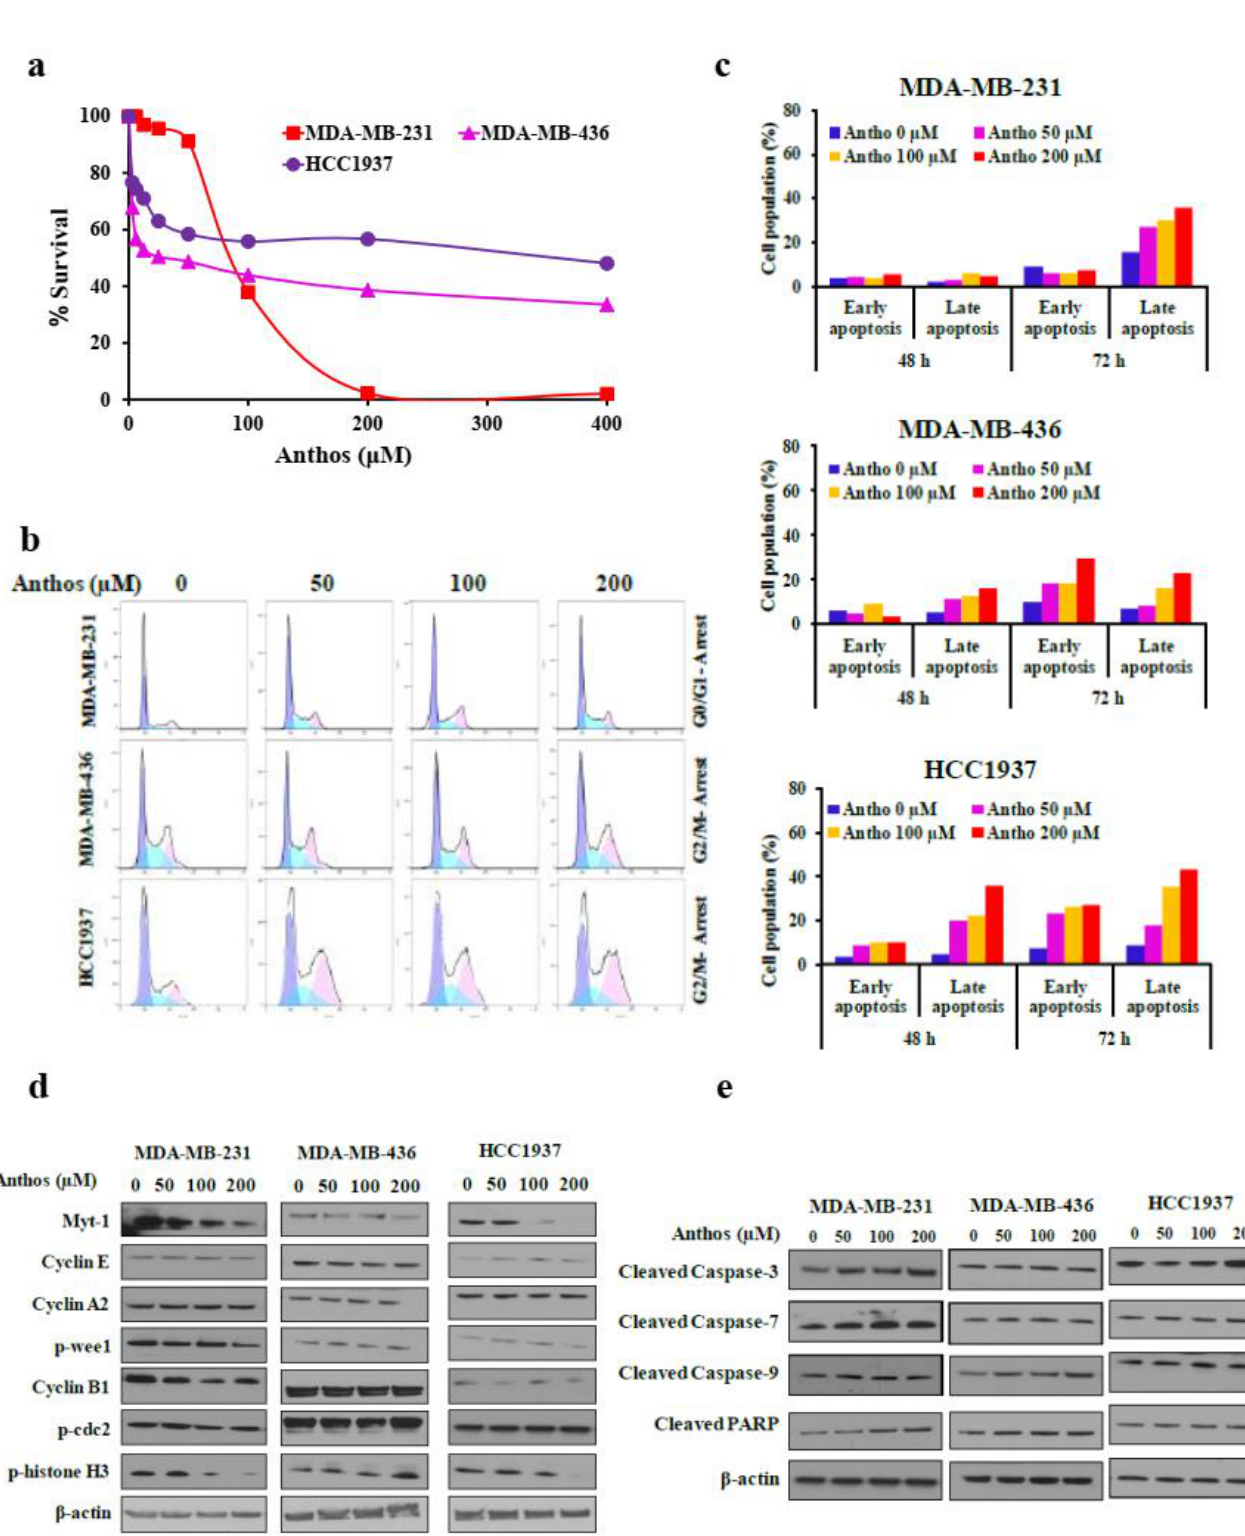
Figure 1. Effect of Anthos on cell viability, cell-cycle progression, apoptosis, and cell-cycle regulatory proteins: ( a ) BC cells were treated with a native mixture of Anthos (0–400 µ M) isolated from bilberry extract for 72 h and MTT assay was performed. Data denote the mean of three experiments (SD < 10%); ( b , c ) MDA-MB-231, MDA-MB-436, and HCC1937 cells were treated with Anthos (0–200 µ M), and cell-cycle arrest ( b ) and apoptosis ( c ) were determined after staining cells with propidium iodide by flow cytometry; ( d , e ) BC cells were treated with Anthos (0–200 µ M) for 48 h and cell lysates were analyzed by Western blot for indicated proteins. Equal loading was confirmed by β -actin. Densitometry data are presented in Figures S2 and